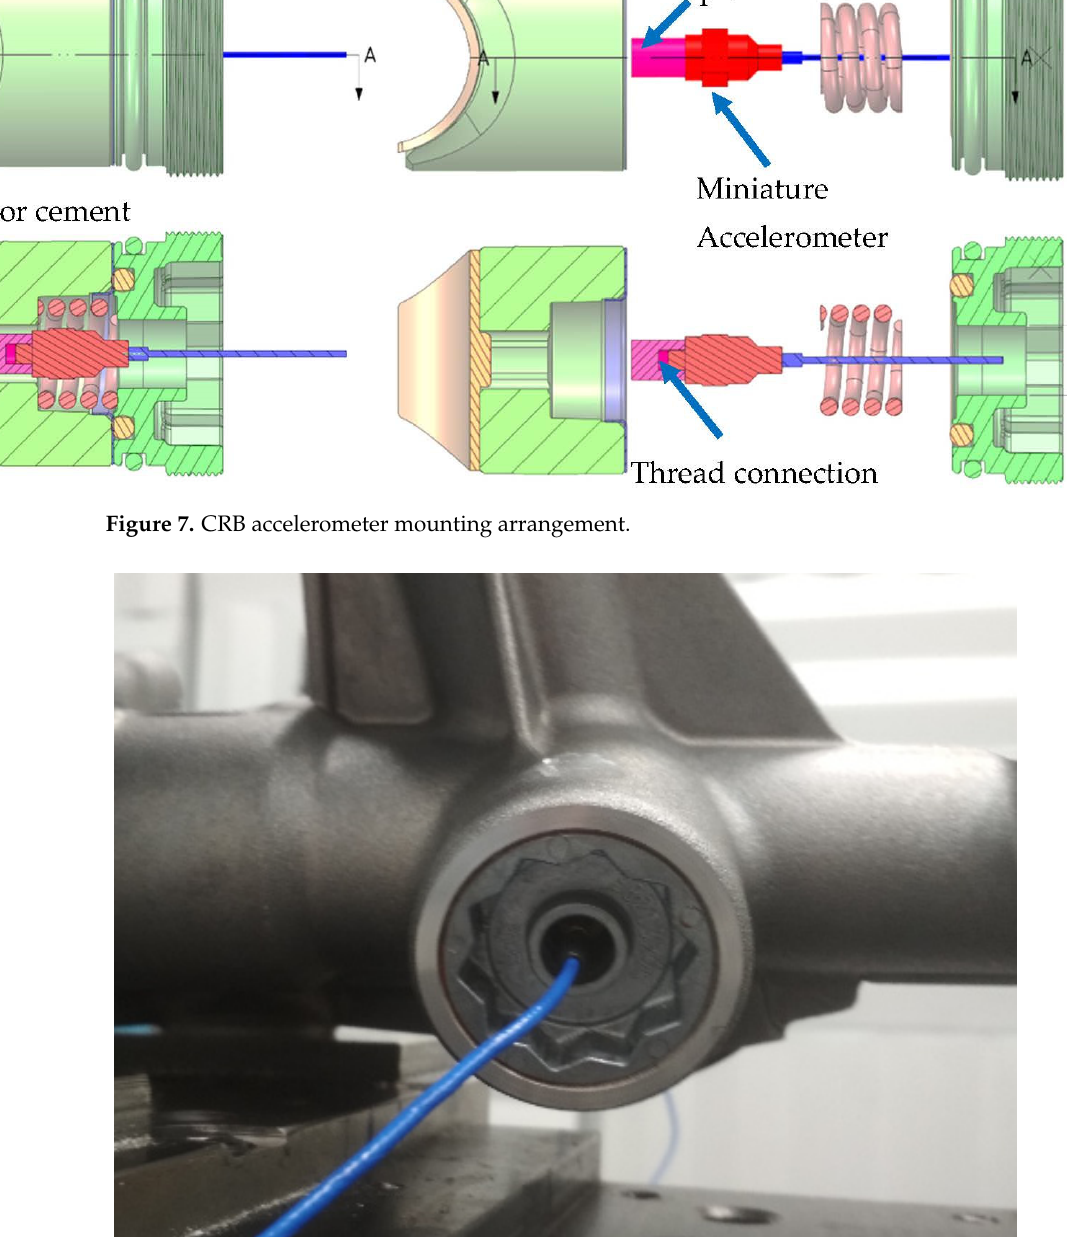
Figure 8. CRB measurement sensor.